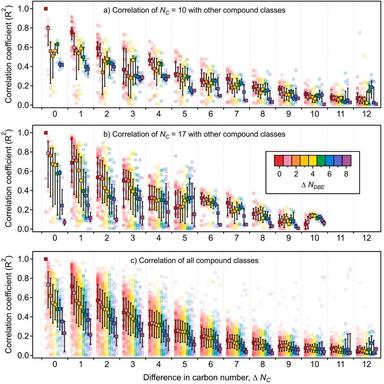
Correlations of measured log-transformed concentrations of hydrocarbons of different classes as a function of difference in carbon number, ΔNC, colored by difference in degrees of unsaturation, ΔNDBE. Correlations are shown for (a) all C10 compound classes to all other compound classes, (b) all C17 compound classes to all other compound classes, and (c) all compound classes to all other compound classes. Light points are all correlations of a given ΔNC and ΔNDBE, with median and interquartile range shown as